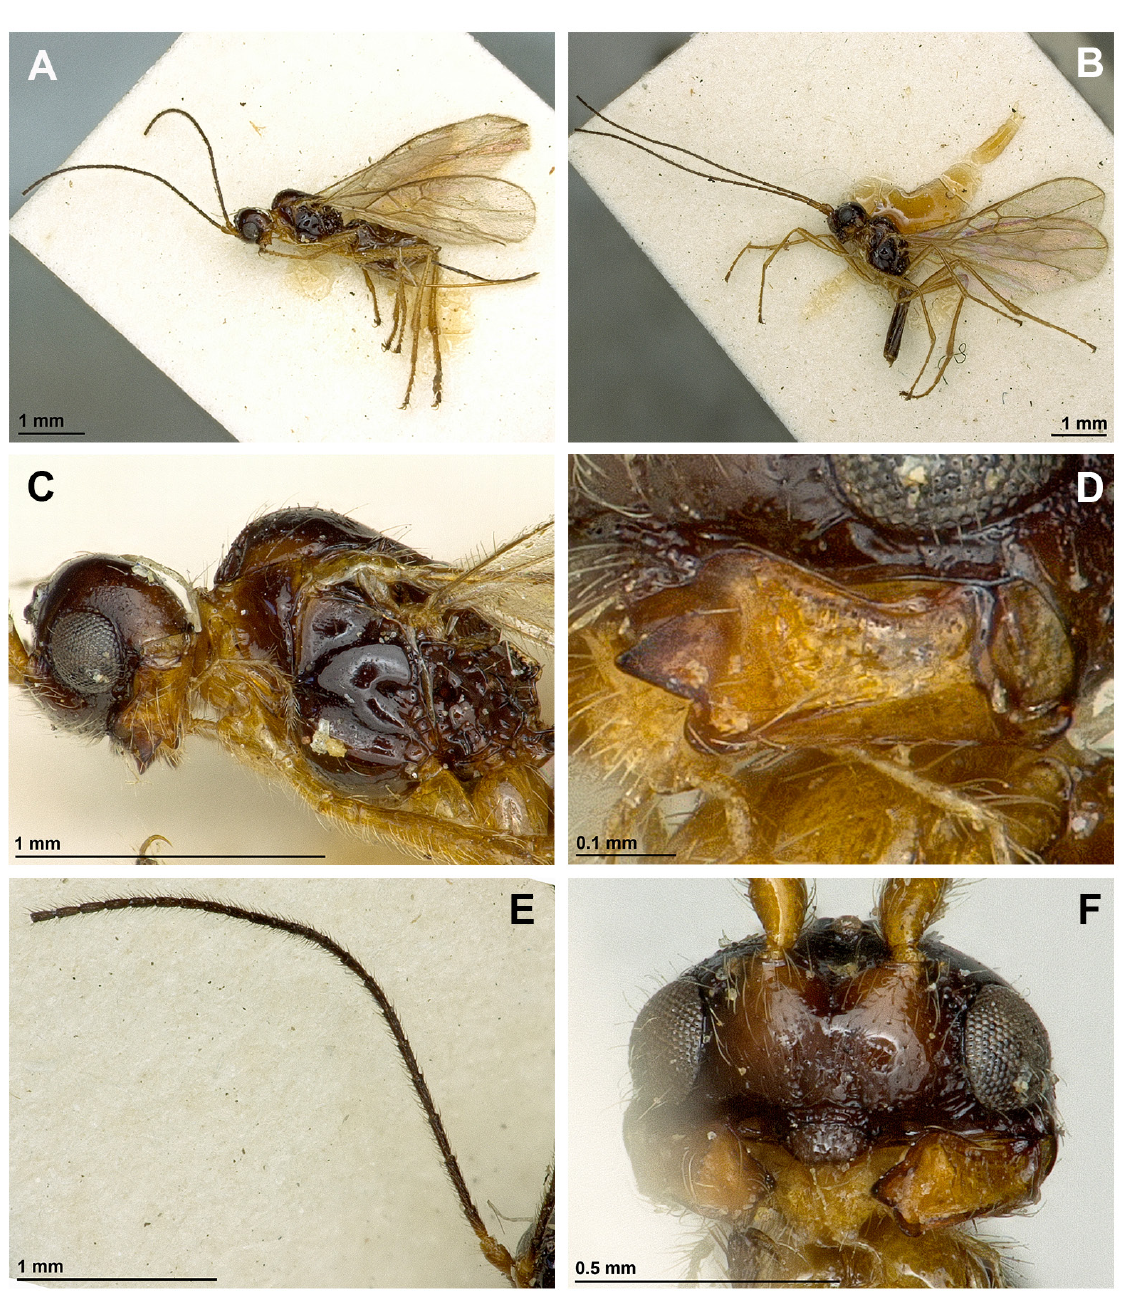
Fig. 1. Asobara abyssiniaensis Peris-Felipo, sp. nov. A, C–F: ♀, holotype (BMNH 459); B : ♂ (BMNH). A–B . Habitus, lateral view. C . Head and mesosoma, lateral view. D . Mandible. E . Antenna. F . Head, front